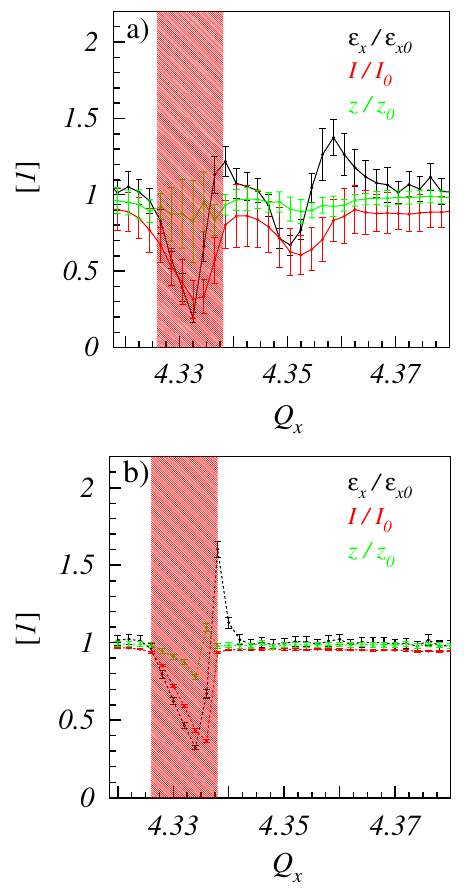
FIG. 13. Low intensity bunched beam: (a) Normalized emit- tance increase, bunch length, and beam loss versus Q x . (b) Simulation of beam loss, bunch length, and emittance increase.